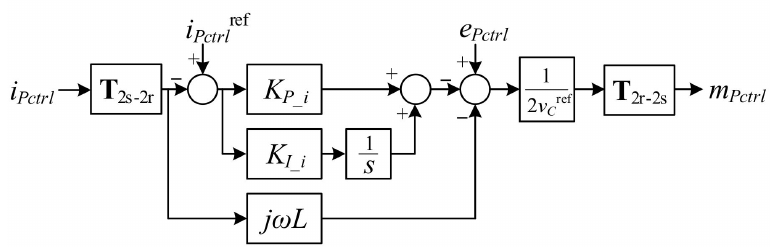
Figure 3. Control Diagram of the Positive-Sequence Current